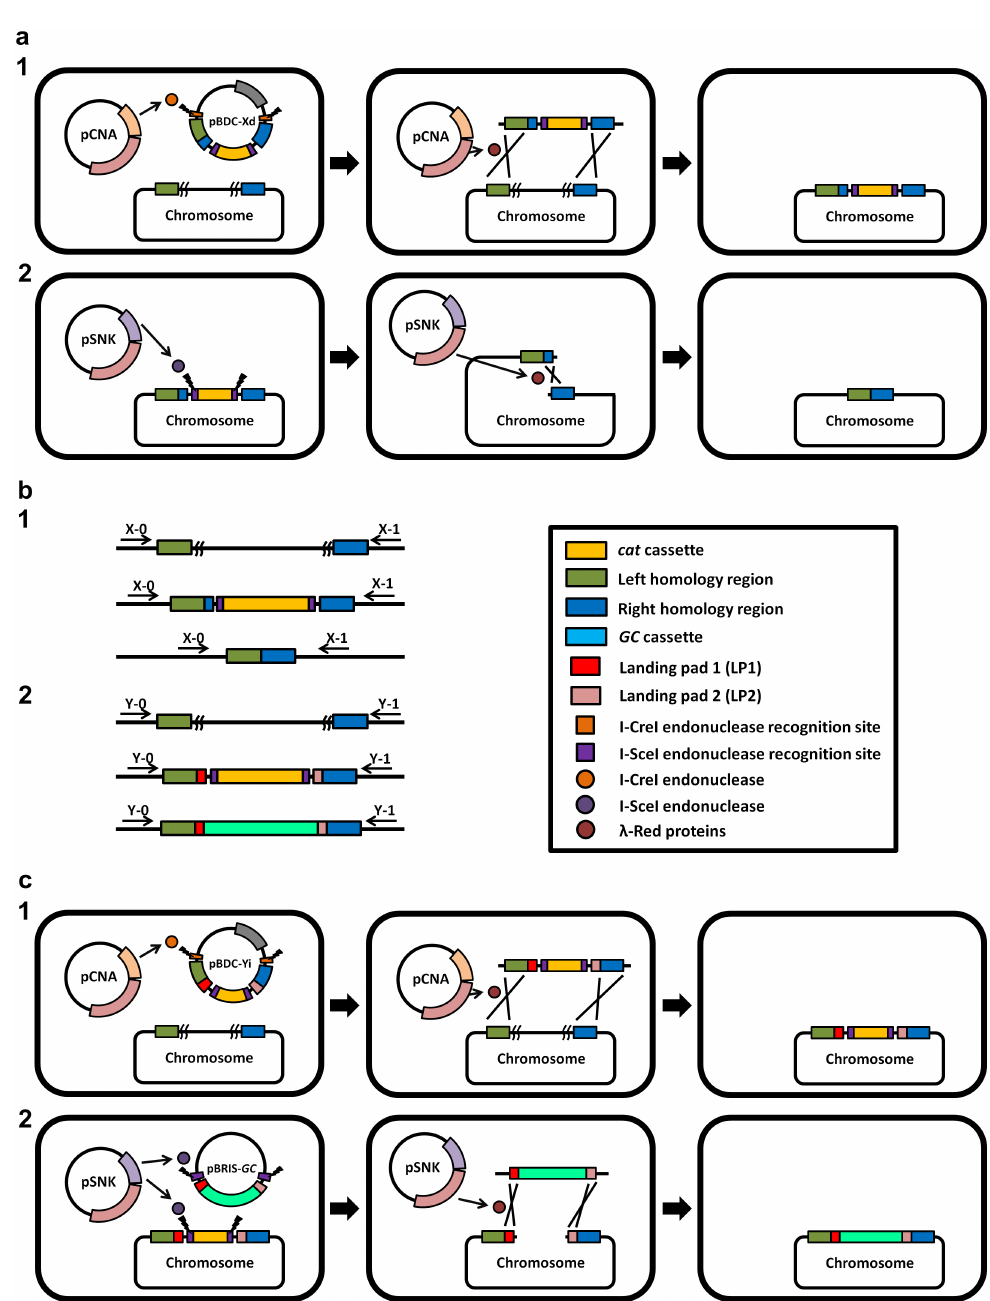
Fig 3. Strategy for markerless deletion and genomic replacement. (a) Progress of markerless deletion. In the first step, the pCNA and pBDC-Xdplasmidswere transformed into E . coli DH1. With the additionof L -arabinose, pCNA expressedI-CreI endonuclease and λ -Red recombinases. The plasmidpBDC-Xdwas digestedby I-CreI endonuclease to release the landingpad fragment, which was the substrate for recombination. The landingpad fragment integrated into the E . coli chromosome. In the second step, the helperplasmidpSNK providing I-SceI endonuclease function was transformed into the host. Finally, the chromosome was cleavedby I-SceI endonuclease at the integrationsite. Recombination with the two homology regions,50 bp of the right side of the left homology arm and left side of the right homology arm, led to chromosomerepair with DSB-mediated recombination and resulted in a clean deletion. (b) Events of identifying markerless deletion and genomic replacement. In the protocolfor markerless deletion,samples were verified by PCR with the primers X-0/X-1 (X = 1, 2, 5, 7, 8, 19, 55, or 63). Positive colonieswere about 2300 bp in the first step and about 1000 bp in the second step. In the protocol for genomicreplacement, samples were verified by PCR with the primers